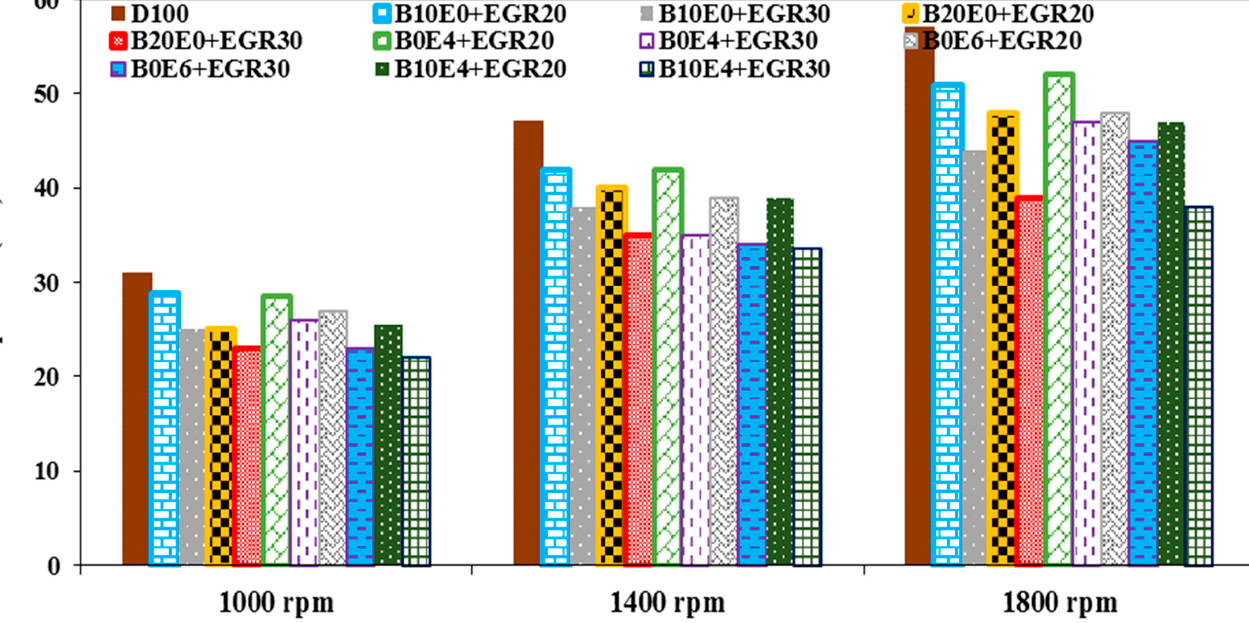
Figure 3. Variation of power for diesel/ethanol/biodiesel blends at EGR = 20%, TiO 2 = 60 ppm, and various engine speeds. The e ff ect of simultaneous EGR = 20% and TiO 2 = 60 ppm on the output power of the diesel–ethanol–biodiesel blends is shown in Figure 3. It can be seen that the B0E4 + EGR20 + TiO 2 60 mixture increased the output power by an average of 2.5% compared to the D100 at di ff erent speeds. 3.2. Torque Torque variations at di ff erent speeds for prepared mixtures with TiO 2 nanoparticles and the EGR system are shown in Figures 4 and 5. Variations of engine torque for diesel-